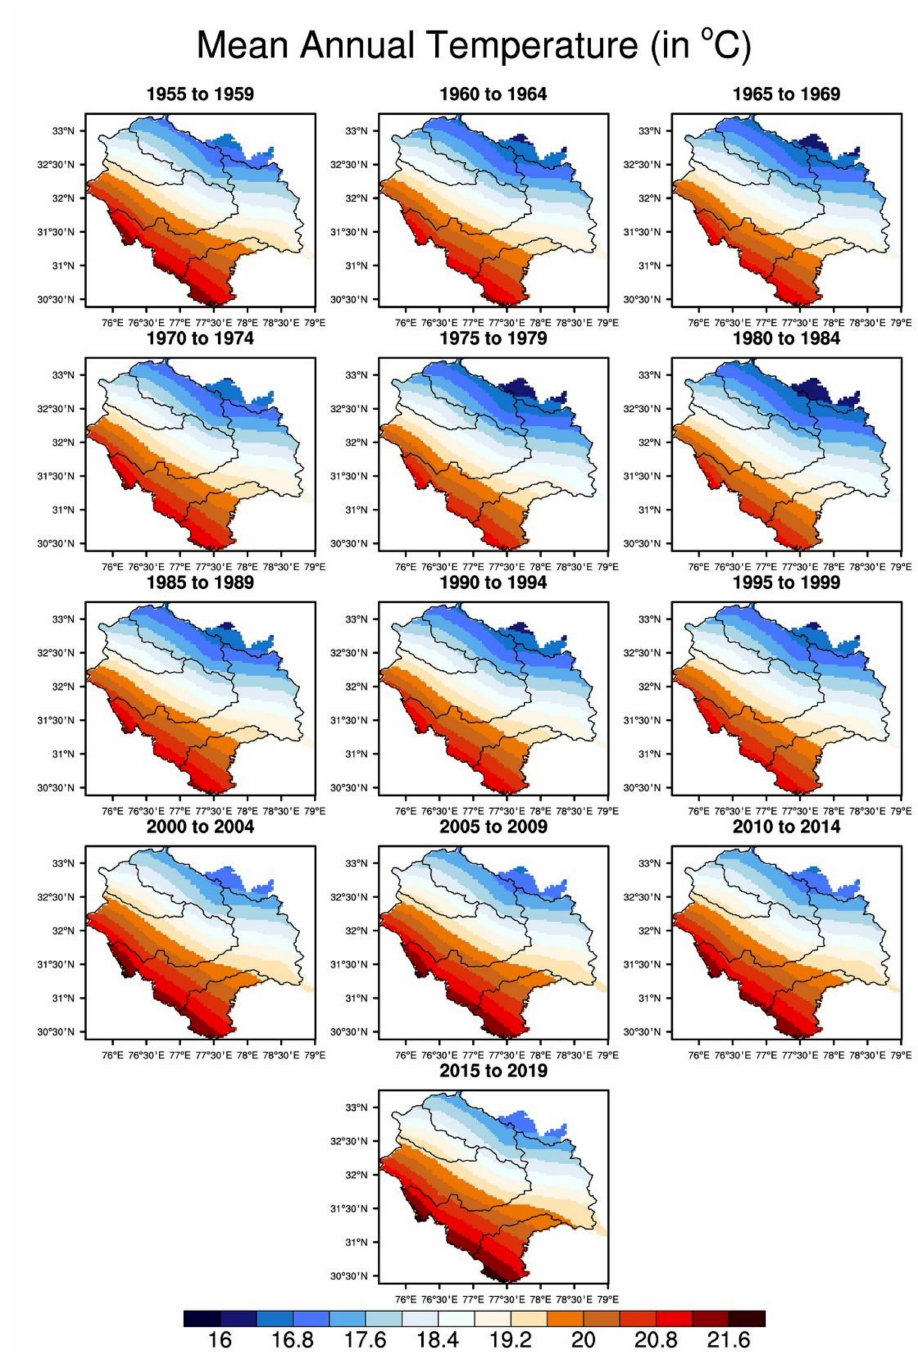
Figure 4. Pentads showing mean annual temperature in five river basins of the Himachal Pradesh. Each pentad shows the mean of the five years from 1955 to